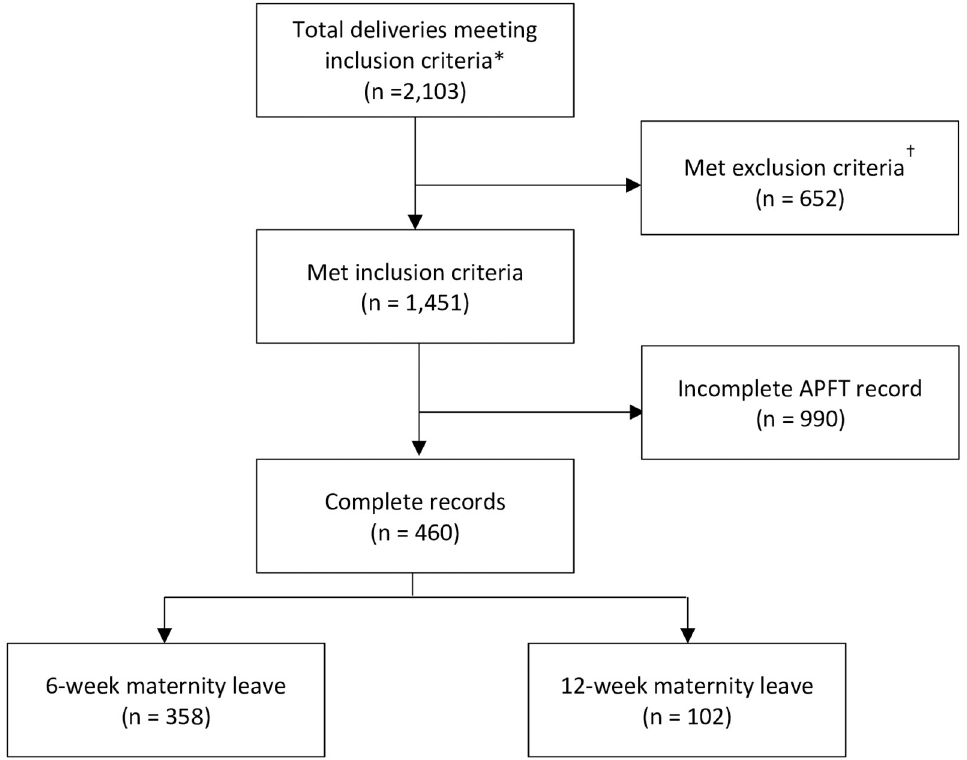
Fig 1. Selection of study participants. APFT, Army Physical Fitness Test. � Inclusion criteria are U.S. Army Servicewomen; delivery of pregnancy at Tripler Army Medical Center; delivery between January 1, 2011 and March 31, 2017; and gestational age at delivery greater than or equal to 32 completed weeks. # Exclusion criteria are duplicate record; multiple gestation; parity of three or more. ## Incomplete APFT record included last pre-pregnancy APFT more than 15 months before new obstetric appointment or record of 1 st postpartum APFT more than 15 months after delivery in the Digital Training Management System.